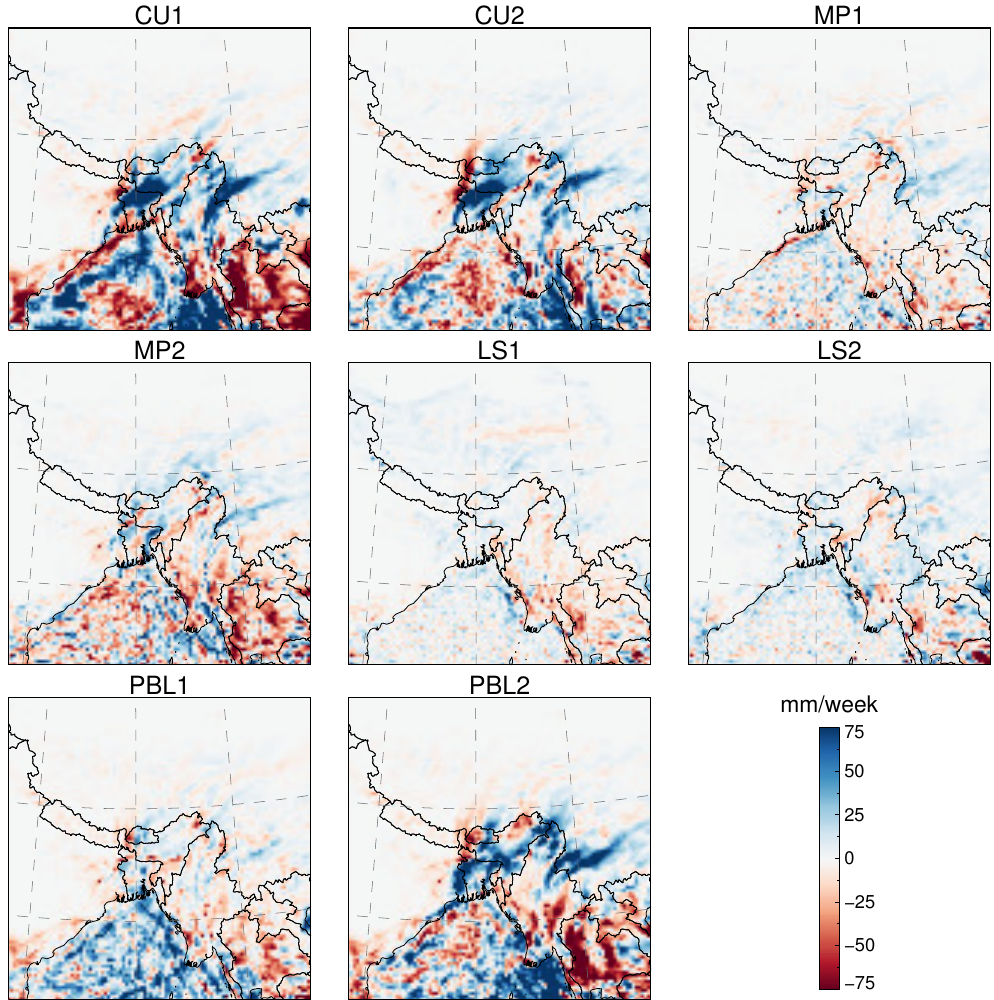
Fig. 9. Sensitivity to the physical parameterisation schemes. Difference between the one-week precipitation (mm/week) of the sensitivity experiments and the RE for WRF30 over a subset of the LD.